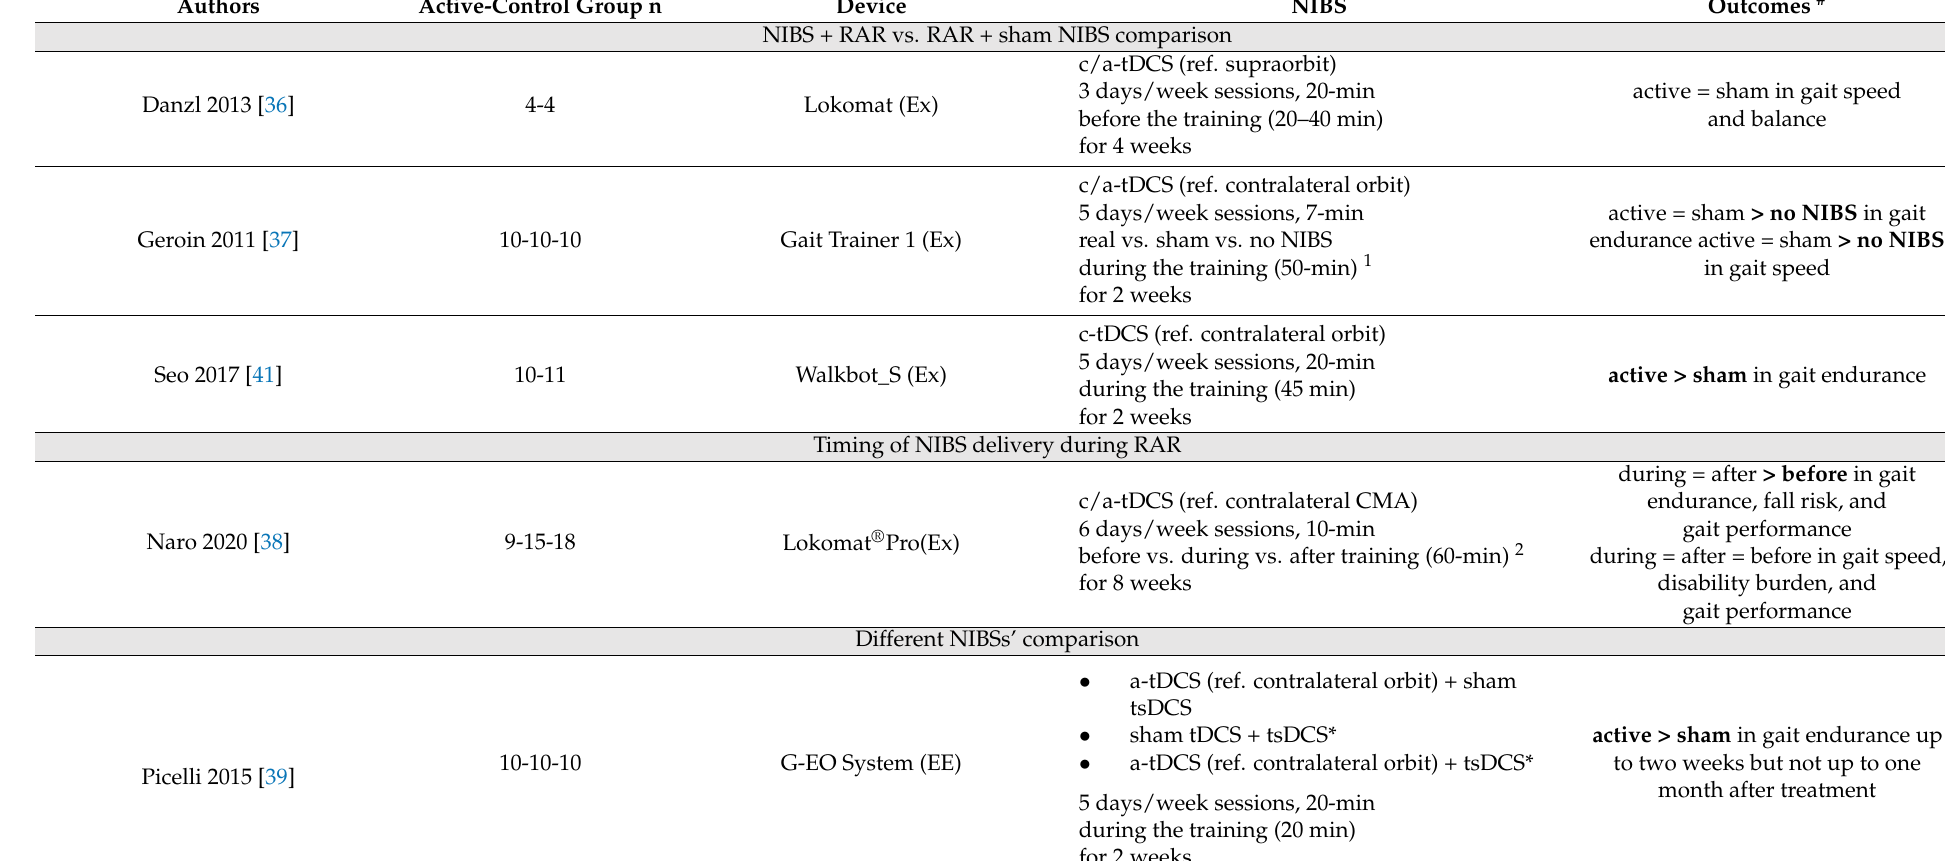
Table 2. Characteristics of lower limb